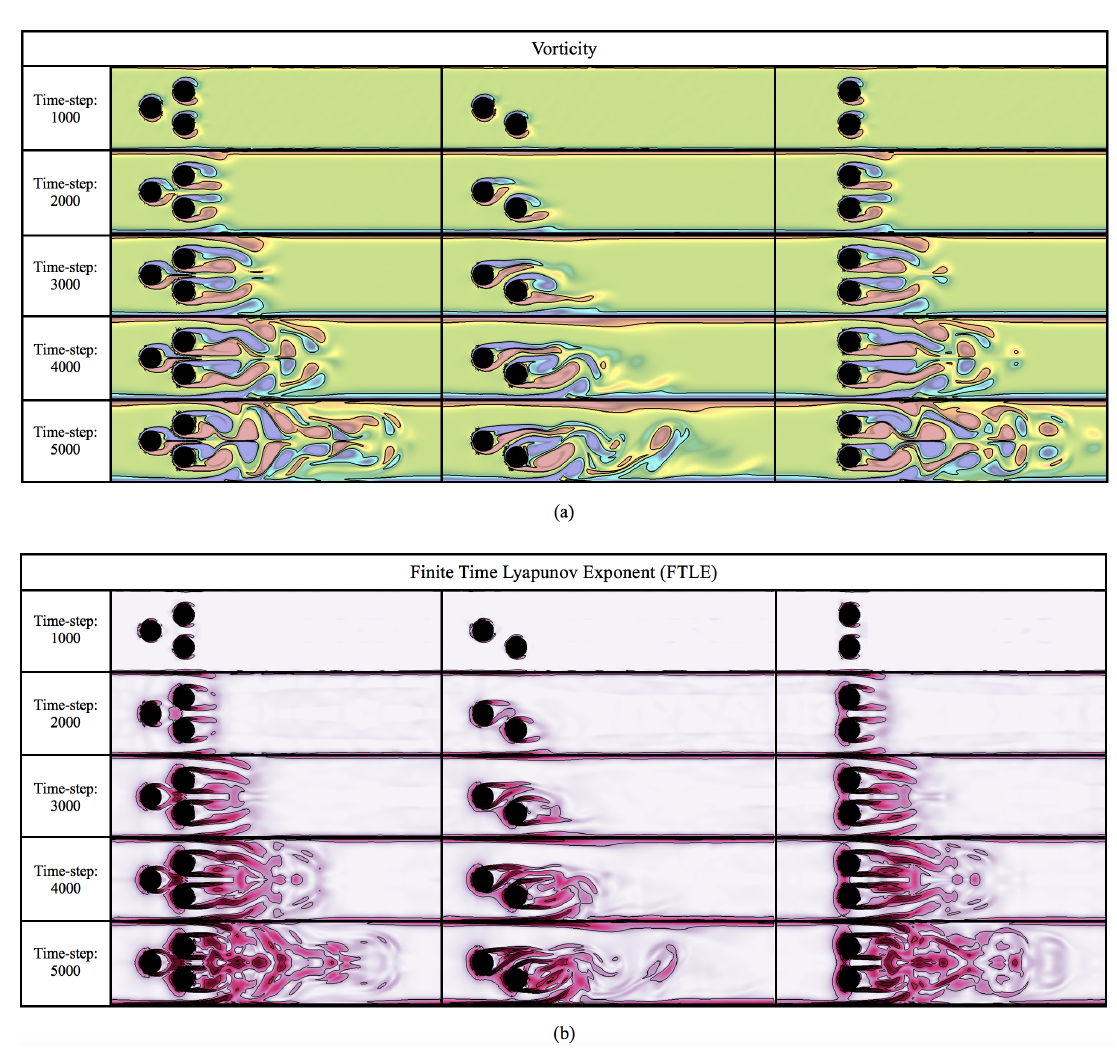
Figure 36. Snapshots from simulations of multiple cylinders in different configurations showing ( a ) vorticity and ( b ) finite-time Lyapunov exponents with their contours, respectively. Note that the colormaps are the same as used in Figure